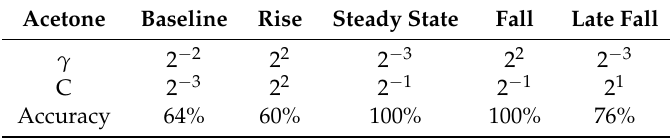
Table 7. Cross validation results for a mixture of acetone and